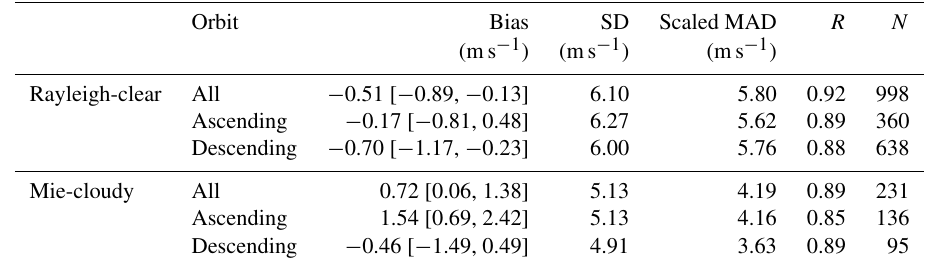
Table B1. Results of inter-comparison with ground-based WPR measurements based on the error estimate threshold values of 7ms − 1 for Rayleigh-clear and 5ms − 1 for Mie-cloudy winds. Orbit Bias SD Scaled MAD R N (ms − 1 ) (ms − 1 ) (ms − 1 ) Rayleigh-clear All Ascending